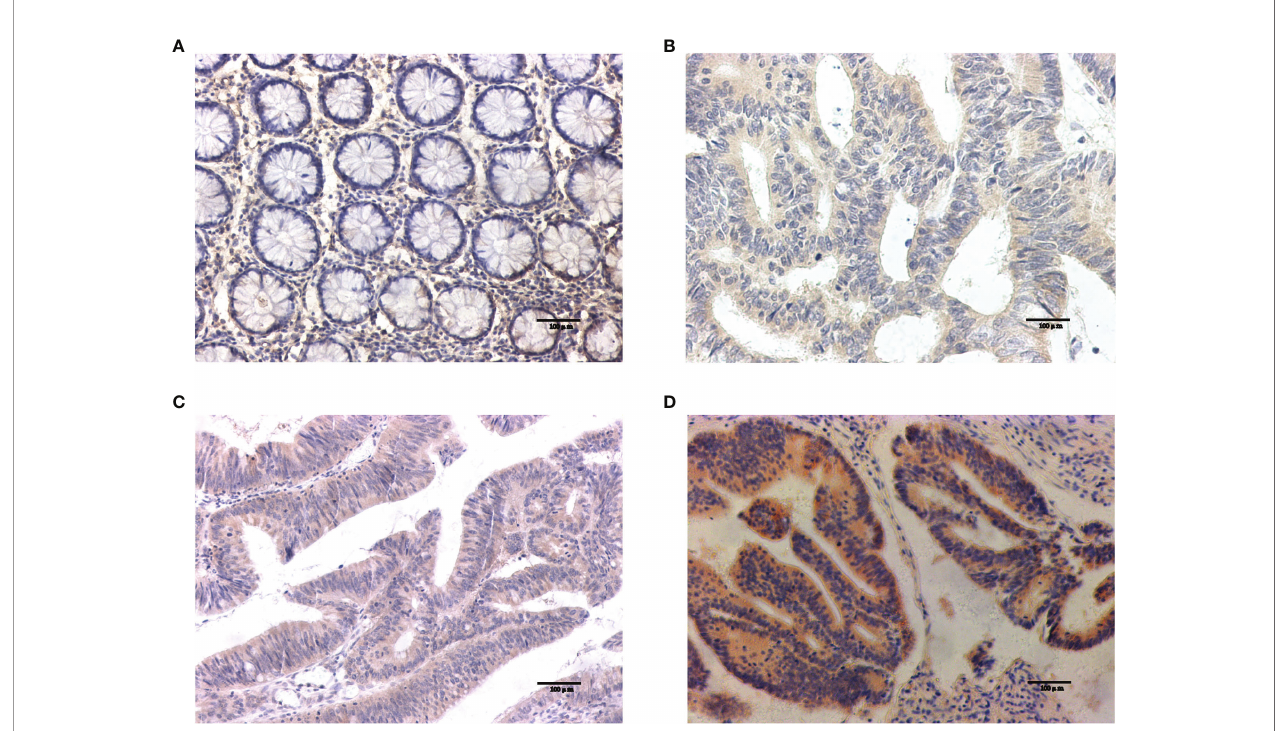
FIGURE 13 | Results of NOS2 immunohistochemistry. (A) Negative expression of NOS2 in normal tissues. (B – D) The weak positive, moderate strong positive and strong positive expression of NOS2 in tumor tissues, in